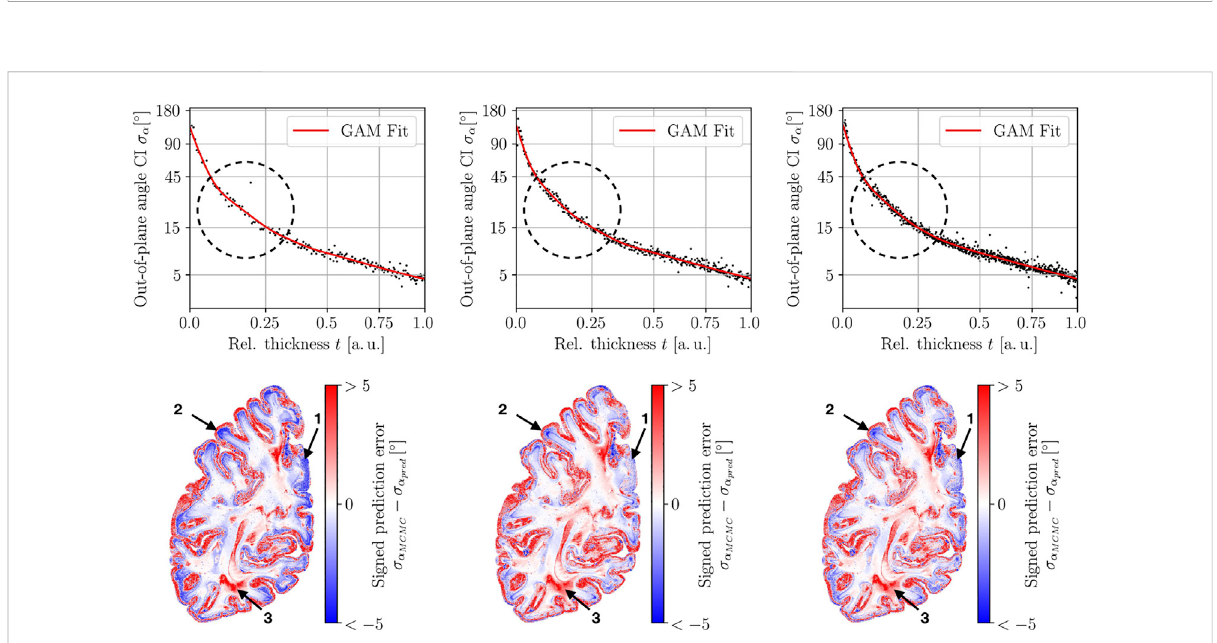
FIGURE 6 Evaluation of three different training data sizes for predicting the out-of-plane angle uncertainty for one brain section. The tested training samplesizesare200,400,and800(lefttoright).Toprow:TrainingdataandGAM fi t.Bottomrow:Mapoftheuncertaintypredictionerror.Thecircle indicatesaregionwherethe fi ttedGAMmodelbecomessmootherforincreasingsamplesize.Thepredictionerrordecreaseswithincreasingtraining samples (arrows 1/2) for some areas at the boundary of white matter and cortex. While white matter mostly expresses small prediction errors, still regions of high prediction errors can be observed in fi ber crossing regions (arrow